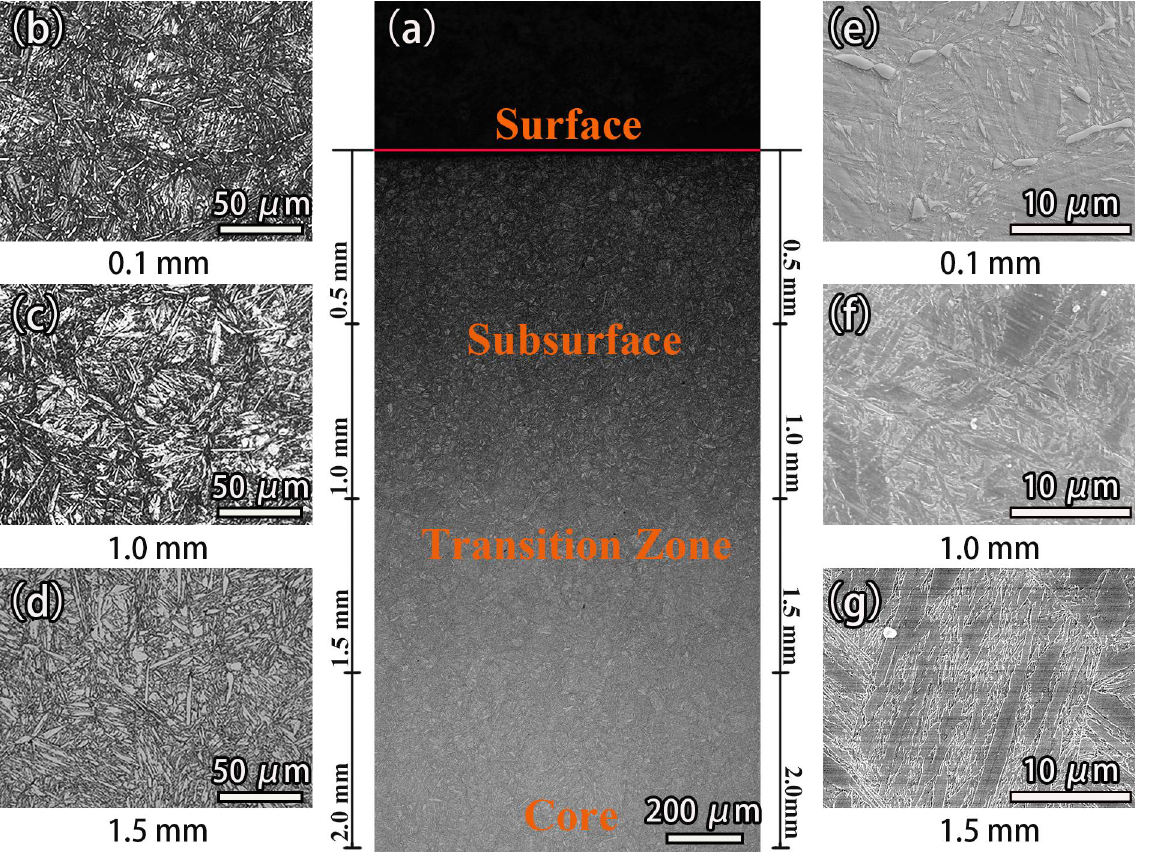
Figure 3. Microstructure of process L2: ( a ) carburizing layer; ( b – d ) OM images of the morphology of the carburized layer at 0.1, 1.0, and 1.5 mm, respectively; ( e – g ) SEM images of the morphology of the carburized layer at 0.1, 1.0, and 1.5 mm, respectively.